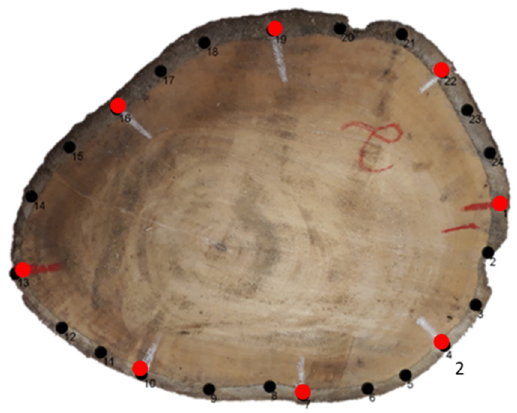
Figure 3. Example of plotting of contour points (black) and measurement points (red) using ImageJ software.